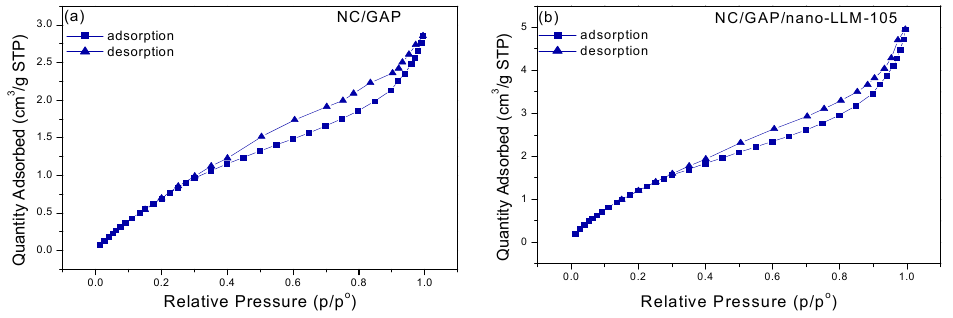
Figure 7. The BET data of samples: ( a ) NC / GAP and ( b ) NC / GAP / nano-LLM-105